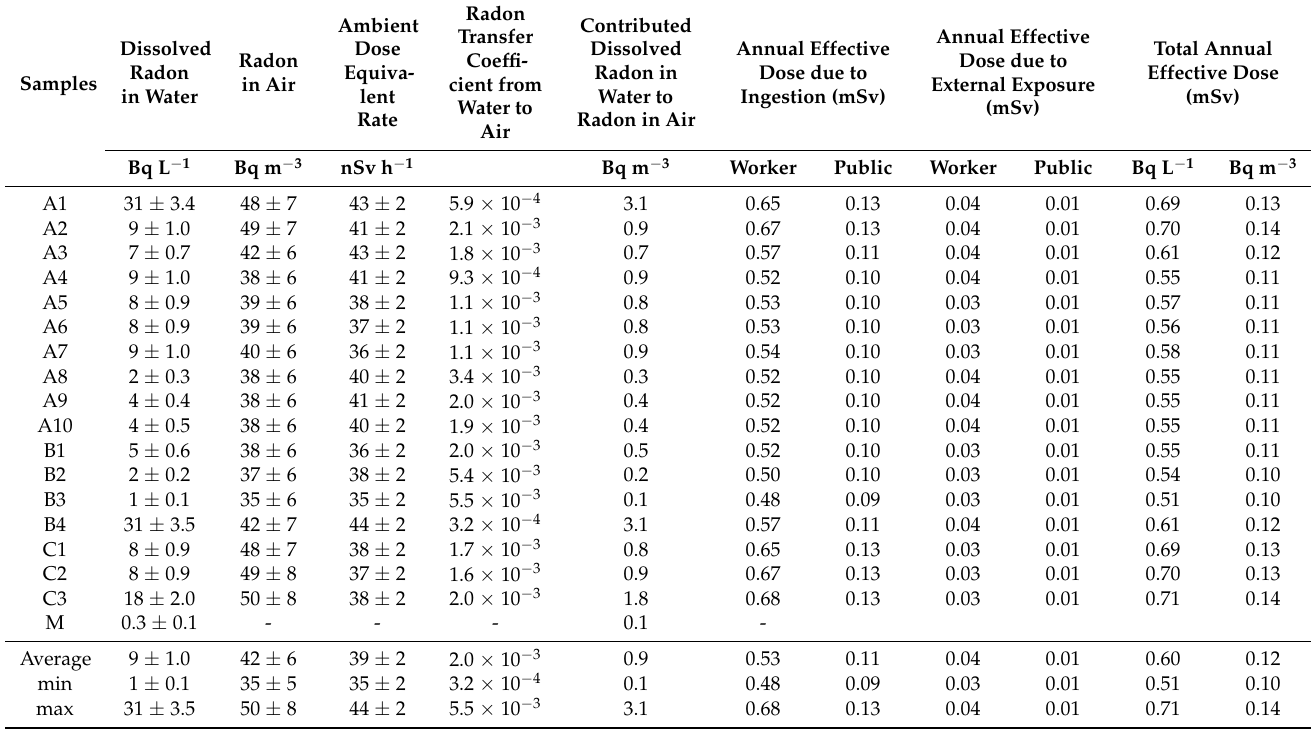
Table 2. Details of measuring result: Dissolved 222 Rn in water, 222 Rn in air, and calculation of annual effective dose.